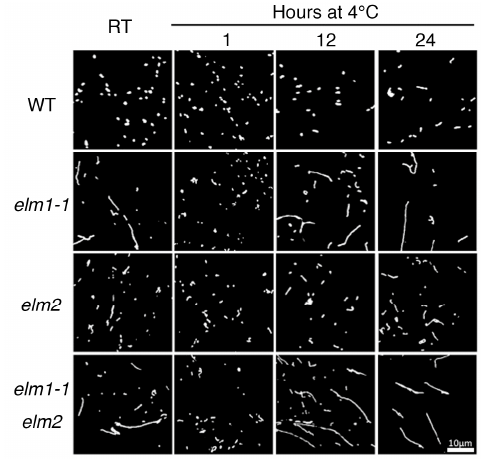
Figure 6. Mitochondrial morphology in the wild type and elm mutants after different durations of cold treatment. Mitochondria were observed in leaf epidermal cells of 28-day-old plants grown at 22 °C before and after different durations of 4 °C treatment. Scale bar, 10 μ m, is applicable to the all images.